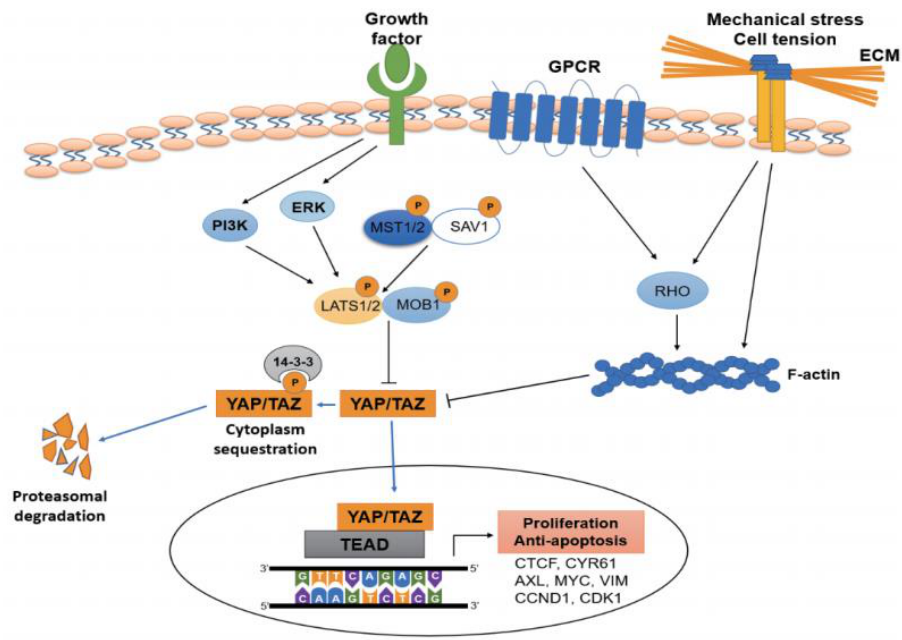
Figure 1. Core components and interacting signals of the Hippo/YAP signaling pathway in cancer. In the canonical Hippo pathway, Mst1/2 and Sav1 activate Lats1/2 and Mob1, which in turn phosphorylate YAP/TAZ. Then, phosphorylated YAP and TAZ are sequestered in the cytoplasm and degraded by proteasomes. Nuclear YAP/TAZ and TEAD complexes induce the transcription of multiple genes that regulate cell propagation and programmed cell death. Several growth factors, G-protein coupled receptors, and mechanical stimuli regulate the activation of YAP/TAZ.